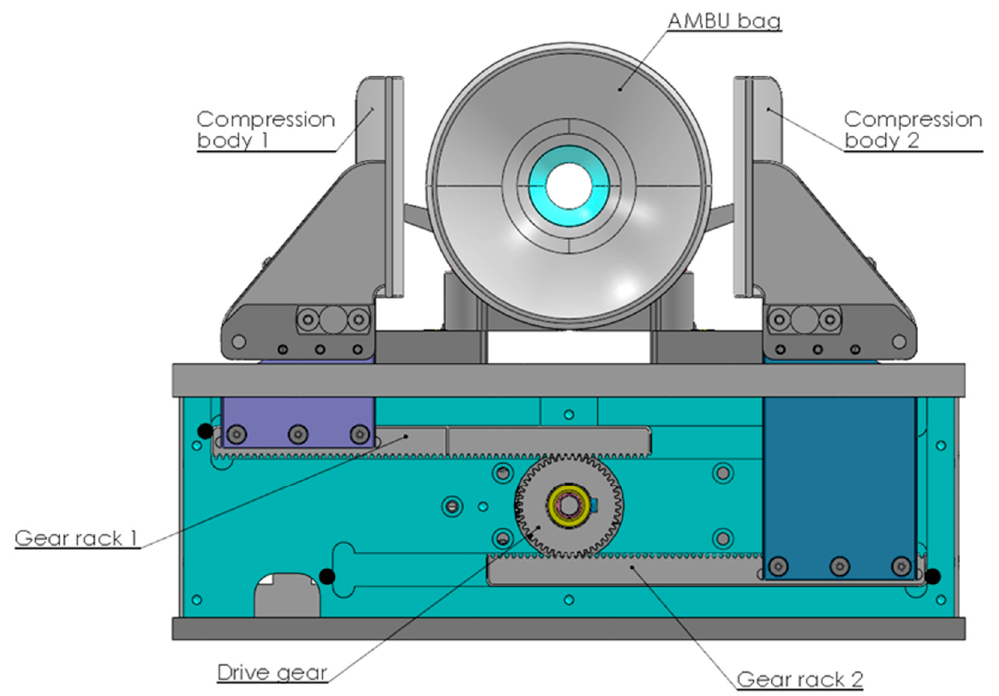
Figure 9. The compression mechanism of the new ventilator concept. It has been derived from the first solution in row 4 of the chart (see [71]).